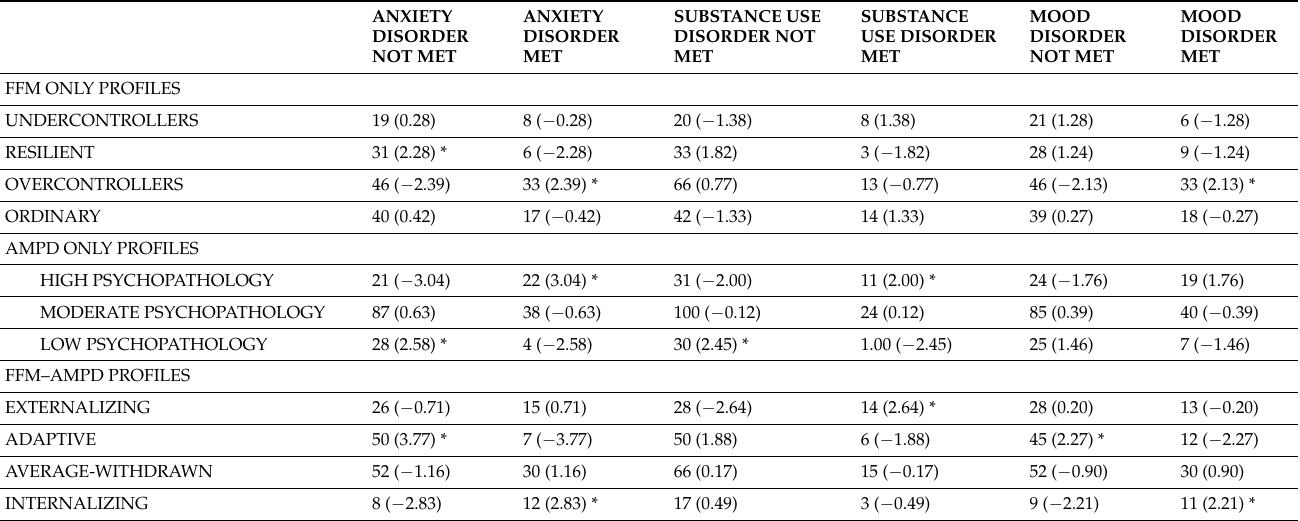
Table 3. Cross-Tabulations of Profile Membership and Criteria met for Current DSM